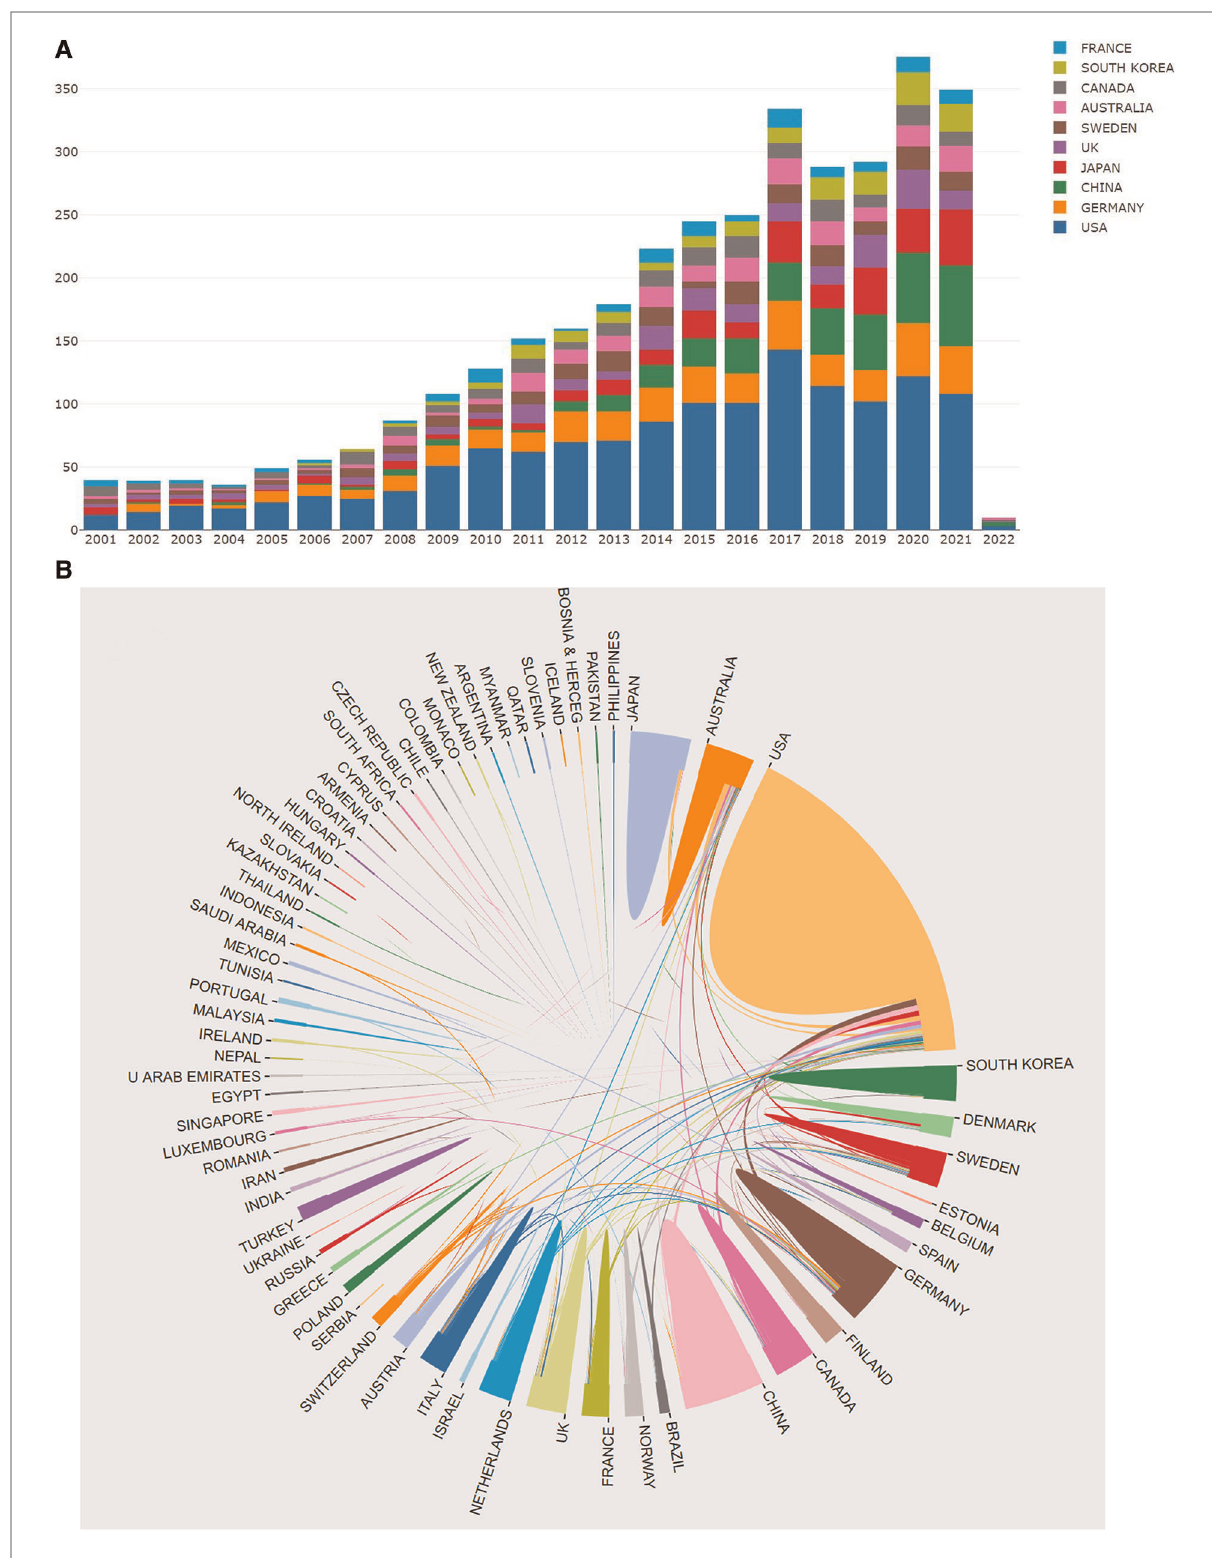
FIGURE 4 ( A ) The annual number of publications by countries. ( B ) International collaboration analysis among different